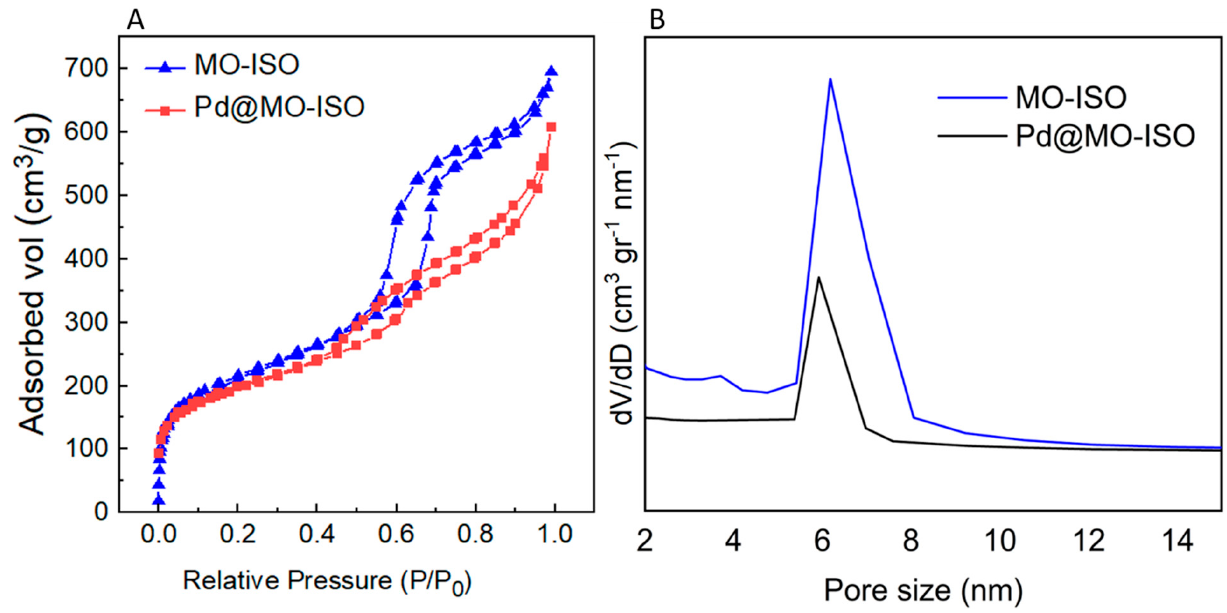
Figure 2. ( A ) N 2 adsorption–desorption isotherms and ( B ) BJH plots of MO-ISO and Pd@MO-ISO. The FTIR spectrum for 1,3,5-tris(2-hydroxyethyl)-1,3,5-triazinane-2,4,6-trione (THEIC), the heterocyclic starting material of ISO bridge, was compared with the FTIR